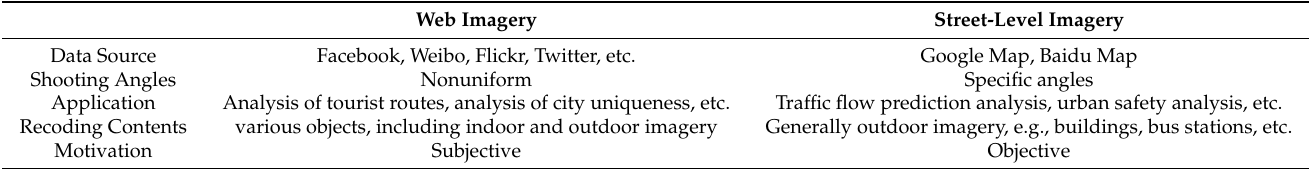
Table 1. Comparison between Web imagery and street-level